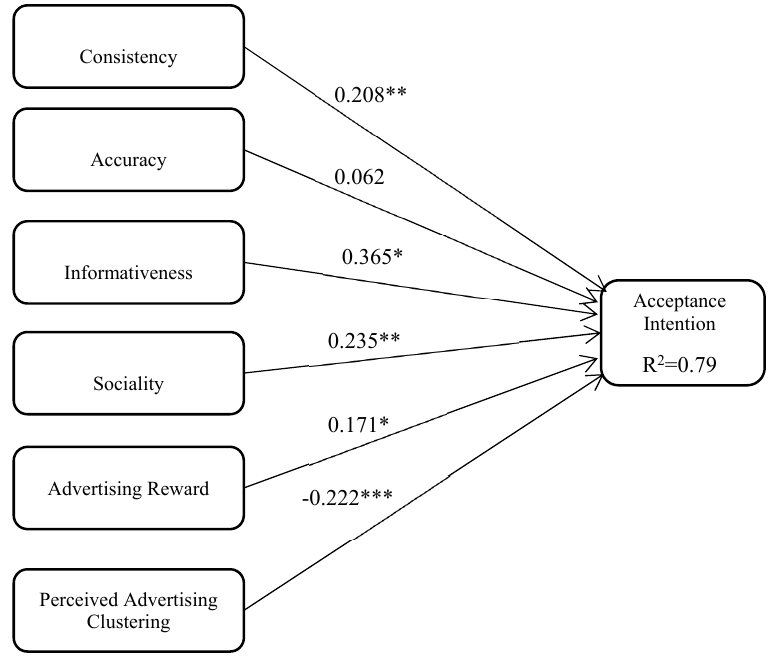
Figure 1. SEM test design (*** denotes p < 0.001, ** means p < 0.01, * indicates p < 0.05; R 2 is the decisive coefficient).